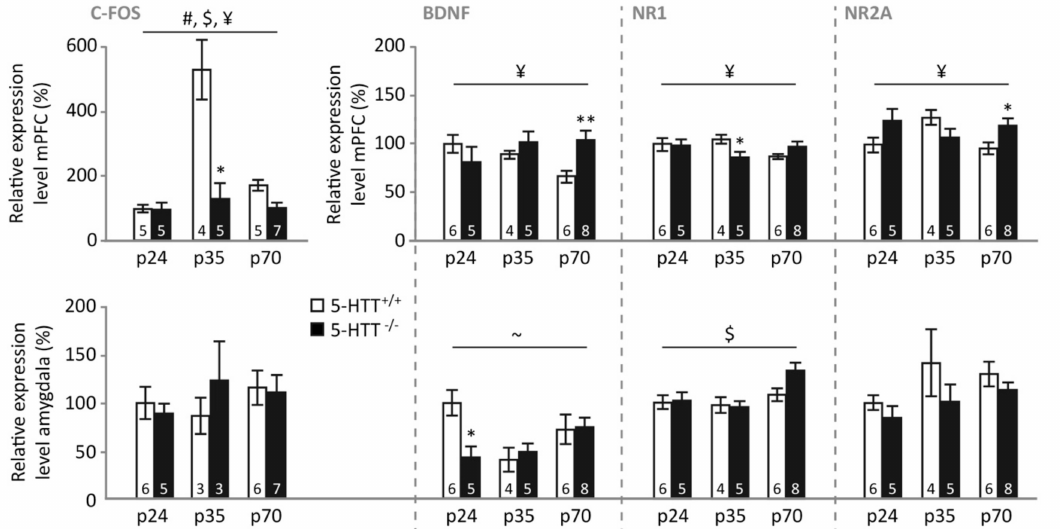
Figure 5. Relative expression levels of c-Fos, BDNF, NR1, and NR2A in the medial prefrontal